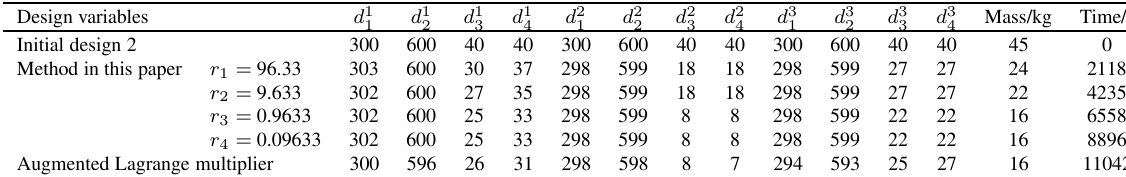
Table 3 Initial feasible design 2 and optimum design (unit: mm)